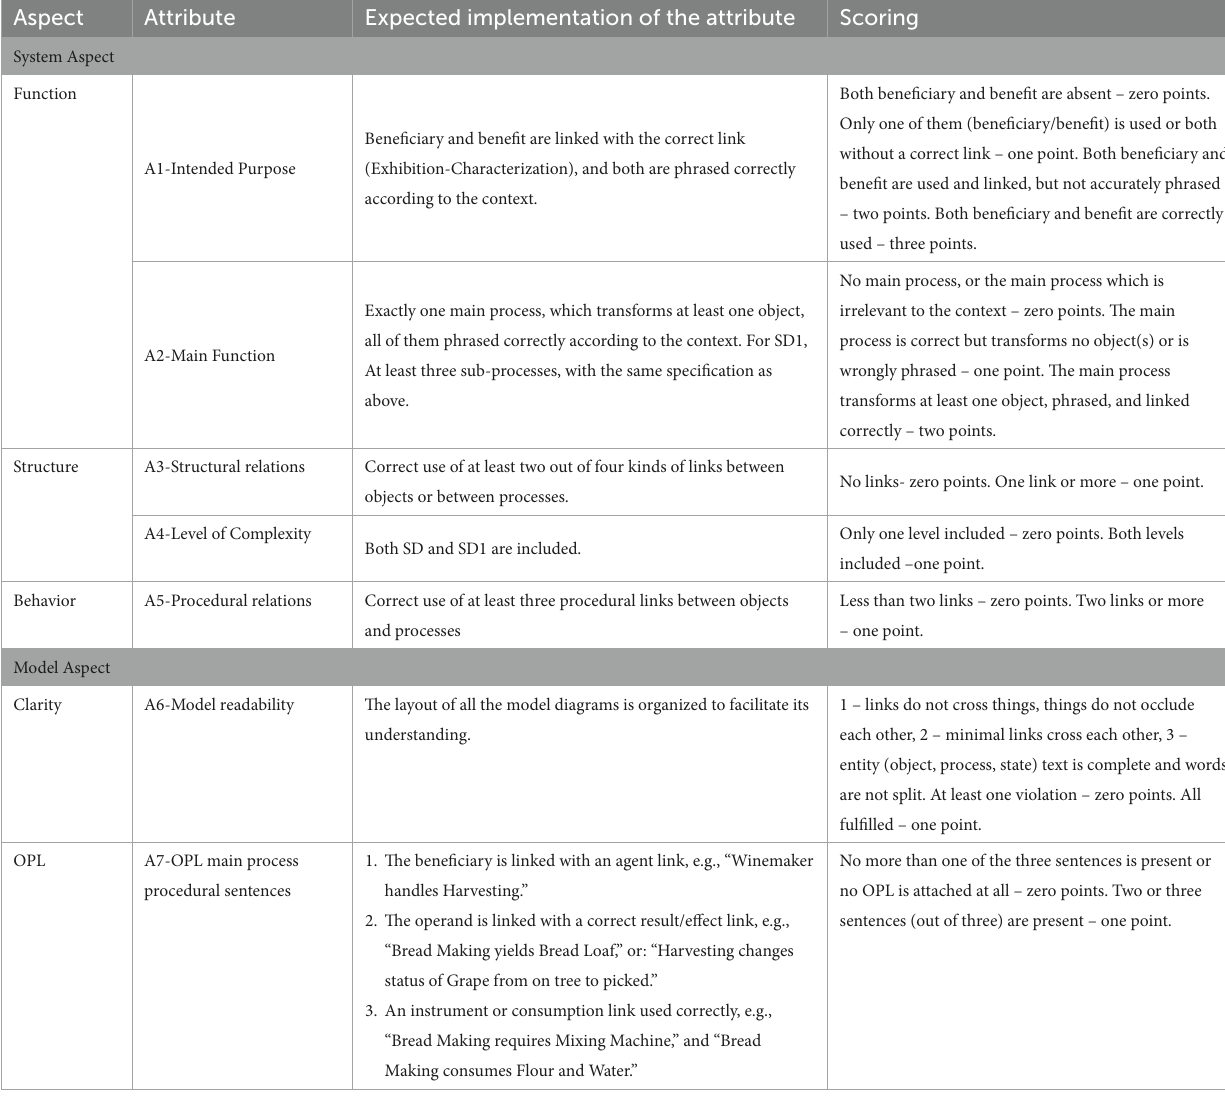
TABLE 5 Modified Systems Thinking Assessment Rubric